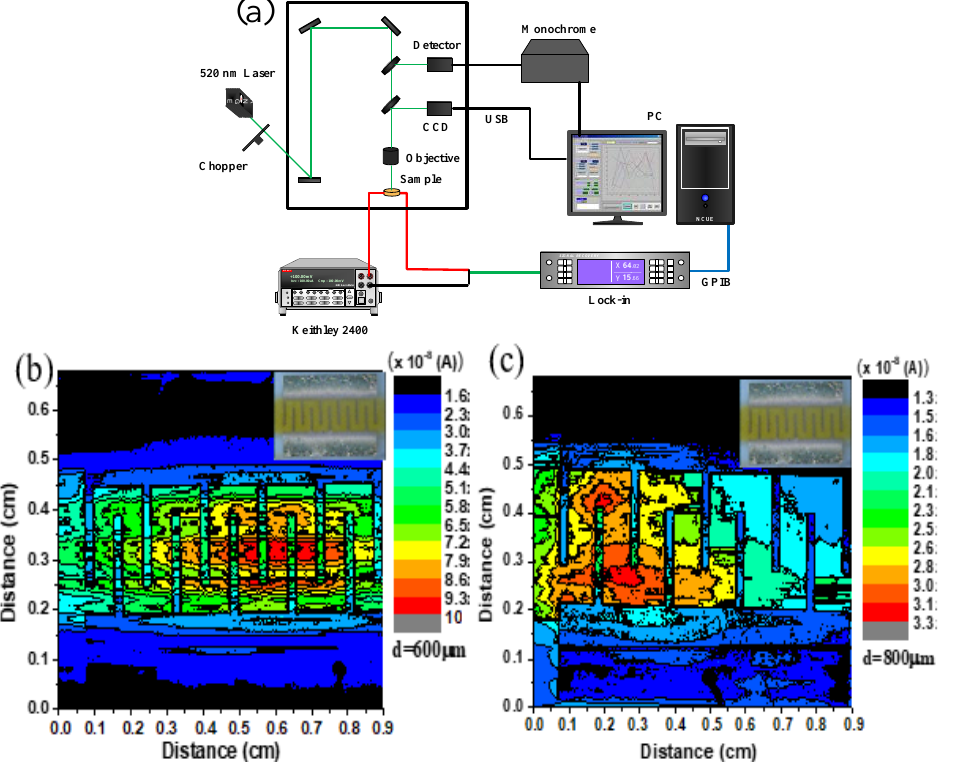
Figure 2. (Color online) ( a ) Scheme of photocurrent measurement: ( b ) and ( c ) 2D photocurrent mapping of SnS 2 films with interdigitated electrodes of 600 and 800 µ m spacing, respectively. Device optical image is in the upper right corner.